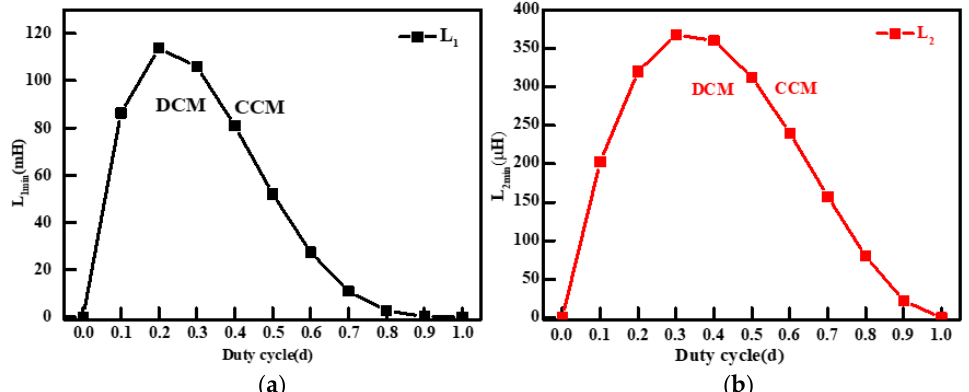
Figure 8. Minimum inductors value requirement for the operation of CCM and DCM and Boundary condition mode ( a ) value of inductor L 1 vs. duty cycle, ( b ) value of inductor L 2 value vs. duty cycle for 150 W load, V in 48 V, V out 400